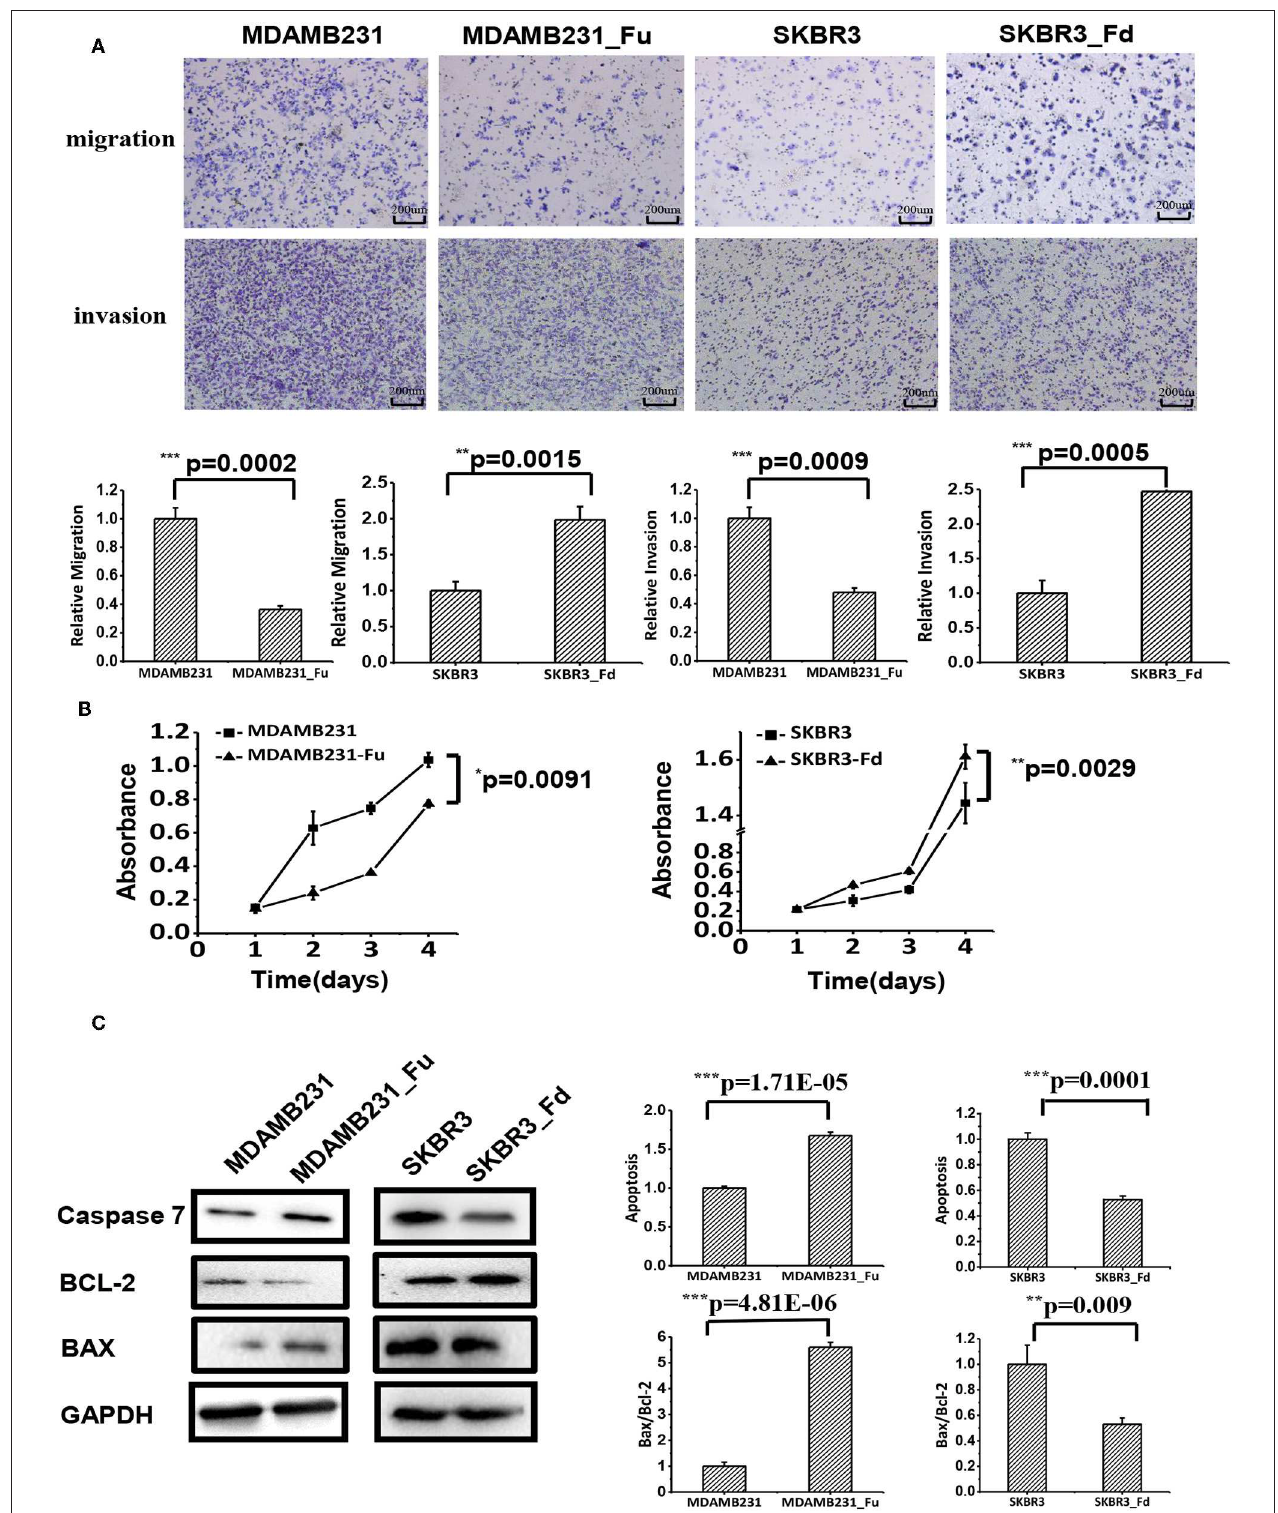
FIGURE 4 | The effects of up- and down-regulating FA2H on cell migration, growth and apoptosis of breast cancer cells. (A) Cell migration of MDAMB231_Fu, MDAMB231, SKBR3_Fd, SKBR3 cells as tested using transwell. (B) The growth of SKBR3_Fd, SKBR3, MDAMB231_Fu, MDAMB231 cells. (C) Apoptosis of SKBR3_Fd, SKBR3, MDAMB231_Fu, MDAMB231 cells as tested on Caspase 7 (apoptosis executioner) expression using Western-blot.